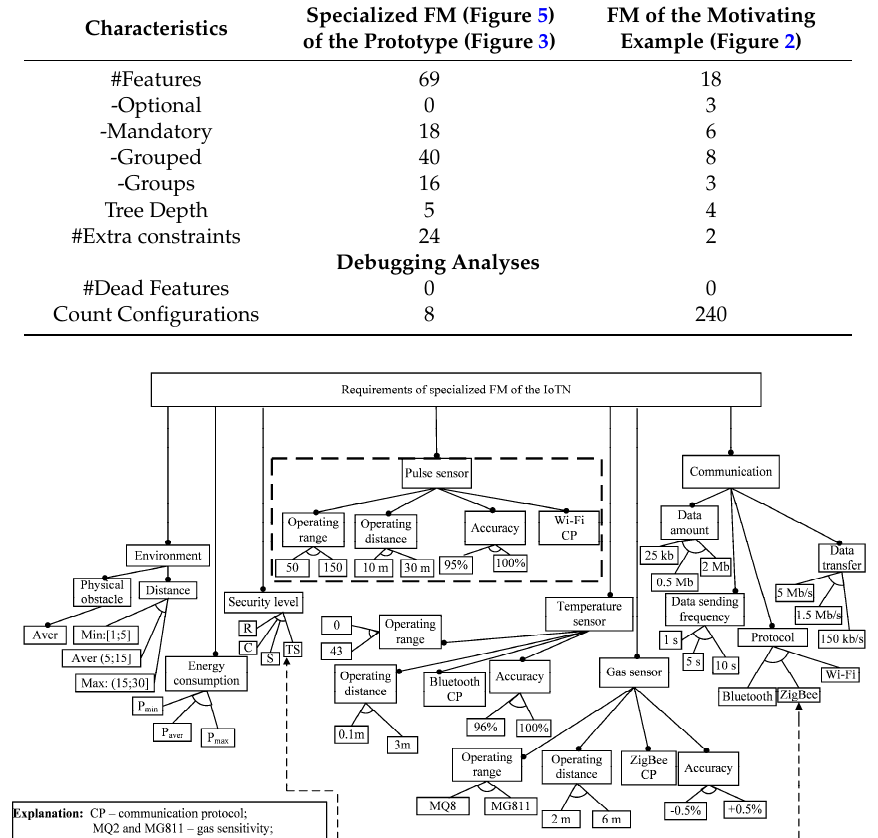
Table 2. Basic metrics of the SC feature model taken from the tool SPLOT.